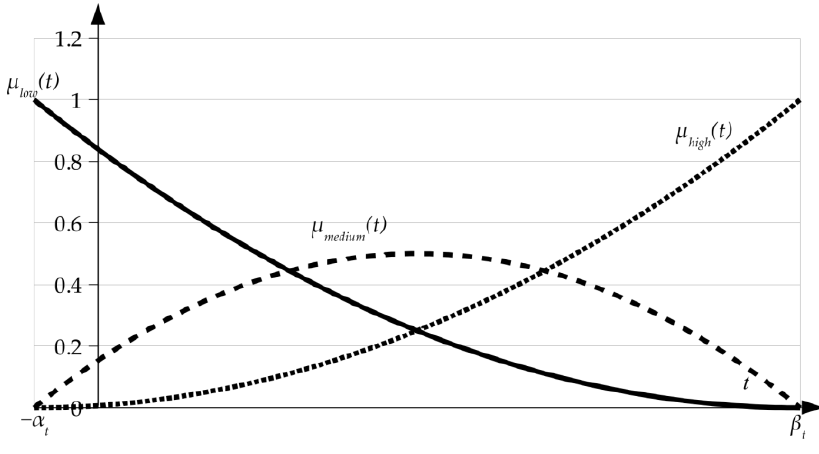
Figure 7. The chart of nonlinear membership functions given by (20) for λ = 1 [20].